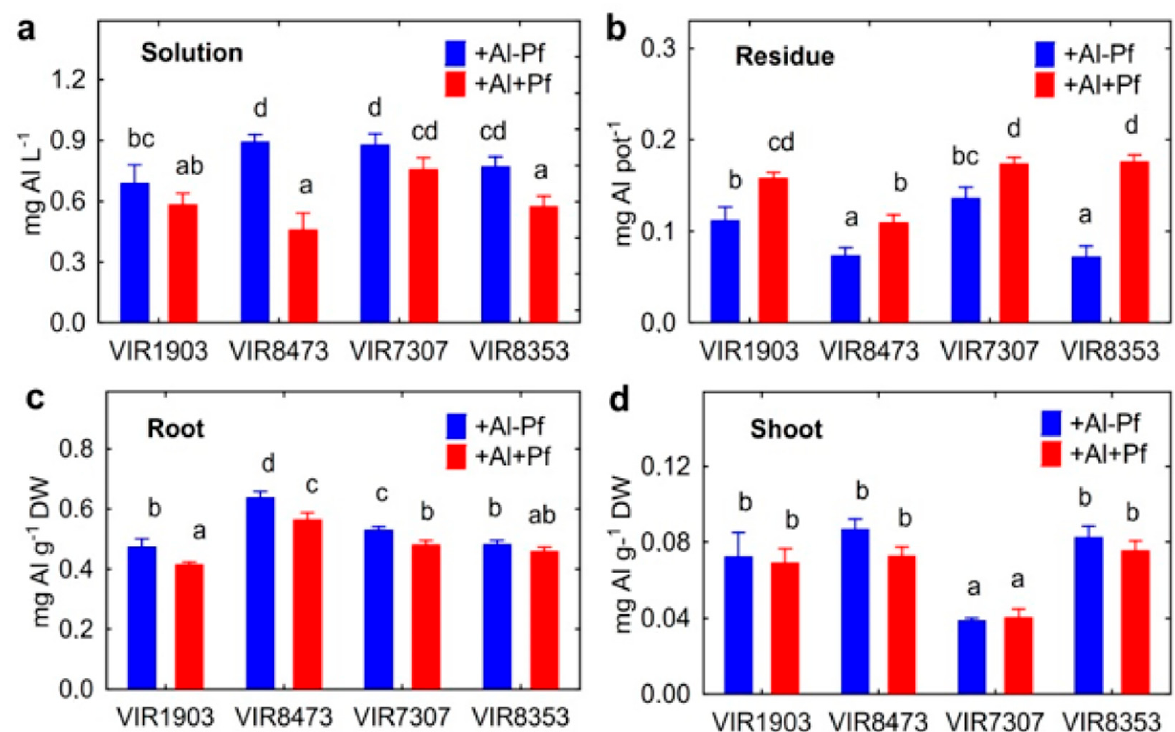
Figure 7. Effect of Pseudomonas fluorescens SPB2137 on Al concentration in the nutrient solution ( a ), aluminum amount in the residue in growth media ( b ) and aluminum concentration in roots ( c ) or shoots ( d ) of pea genotypes VIR1903, VIR8473, VIR7307 and VIR8353 untreated and treated with 80 µm AlCl 3 in the end of experiments. Treatments: +Al-Pf—Al-treated and uninoculated plants, +Al+Pf—Al-treated and inoculated plants. Vertical bars show standard errors. Different lowercase letters show significant differences between treatments (least significant difference test, p < 0.05, n = 3). DW stands for dry weight.